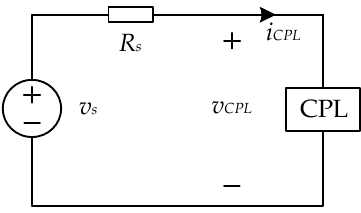
Figure 2. The circuit of voltage source in series with CPL.